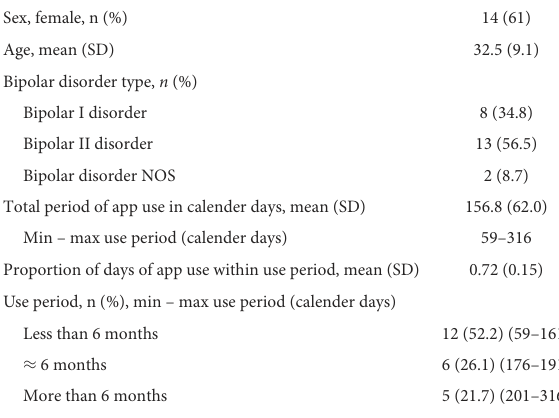
TABLE 2 Characteristics and use data for the first 23 participants included in the MinDag